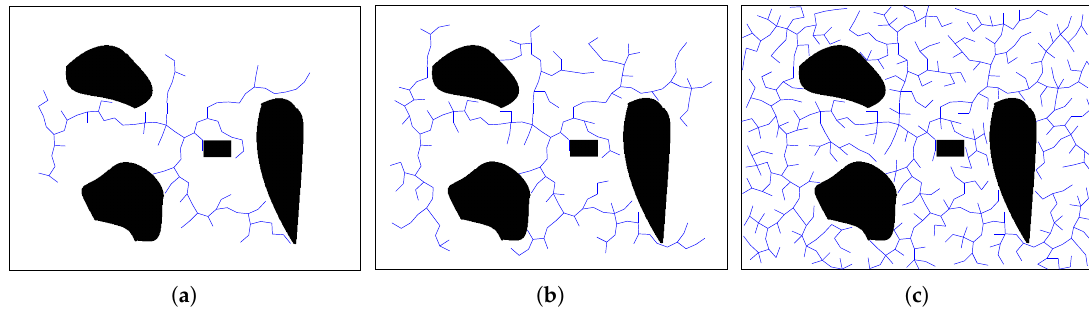
Figure 11. The process of tree growth. ( a ) The 100th step of growth. The random sampling of the whole map leads the tree grown in the map evenly and forms several master branches. ( b ) The 200th step of growth. ( c ) The final step of growth. The tree has finished